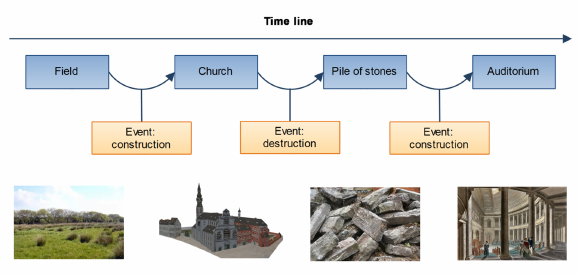
Figure 7. An example of “Modification